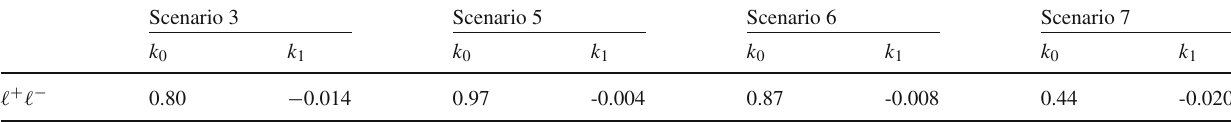
Table 13 Numerical factors used to compute the modified coupling ¯ g Z (cid:2) to reinterpret the cross section predictions in Fig.